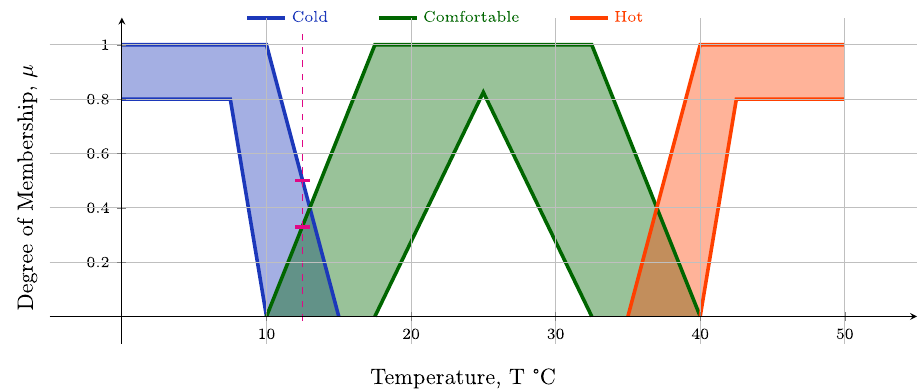
Fig. 6 Membership functions of CoLs that integrate uncertainty handling in xMVPA. An illustrative plot to exemplify how conceptual labels (CoLs), which can be used to describe thermal comfort based on the room temperature (T ∘ C), are characterised with uncertainty handling in xMVPA. Thermal comfort can be expressed with the CoLs cold , comfortable, and hot with an approximate degree of membership values, μ , obtained from ref. 54 . As can be seen in the fi gure, the de fi nition of CoLs is not necessarily mutually exclusive, i.e., a certain temperature can be represented using more than one CoL with varying degrees of membership. For example, the temperature of 12 ∘ C has a degree of membership, μ , in the range of (0, 0.5) for cold and (0, 0.33) for comfortable . The derived ambiguity in the degree of membership ensures that uncertainty in the numeric data (or neuroimaging reading from fNIRS) is well retained upon transformation into a